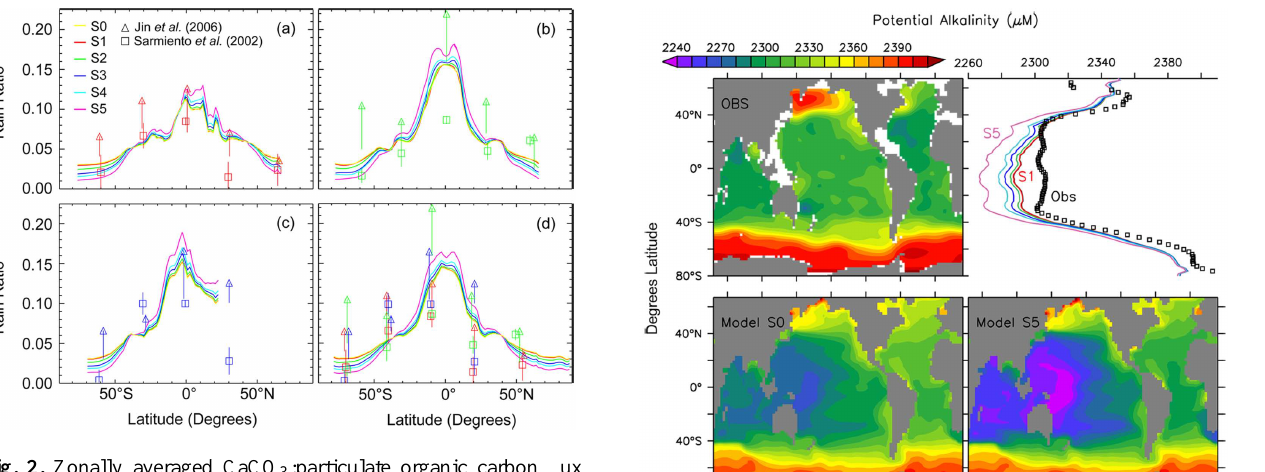
Fig. 2. Zonally averaged CaCO 3 :particulate organic carbon flux (rain ratio) across 130m depth in comparison with observational estimates from Sarmiento et al. (2002) (square symbols) and Jin et al. (2006) (triangles) including their reported error bars (vertical lines) for the (a) Atlantic, (b) Pacific, and (c) Indian Oceans as well as (d) the global model mean. Fig. 3. Comparison of observed (top left) and modelled (bottom)